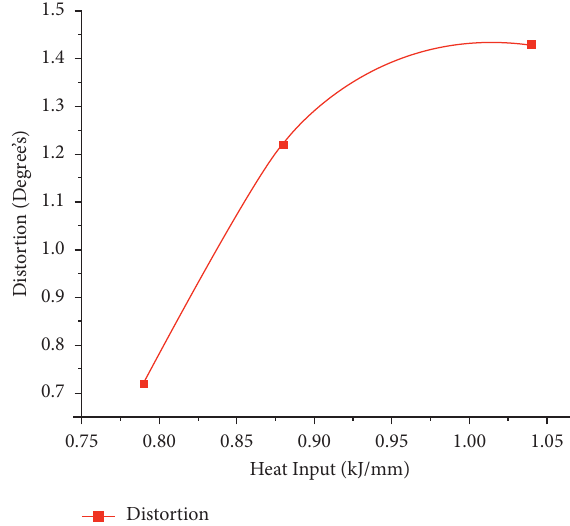
Figure 5: Weld distortion as a function of total heat